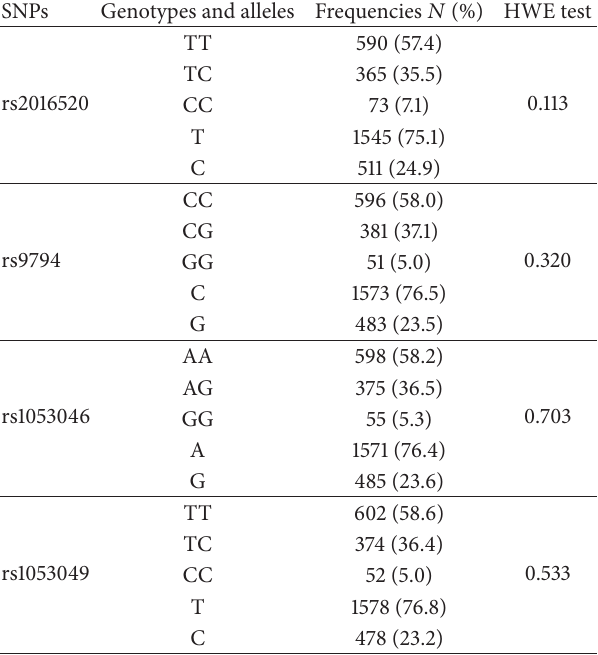
Table 2: The genotype and allelic frequencies distribution in the 1028